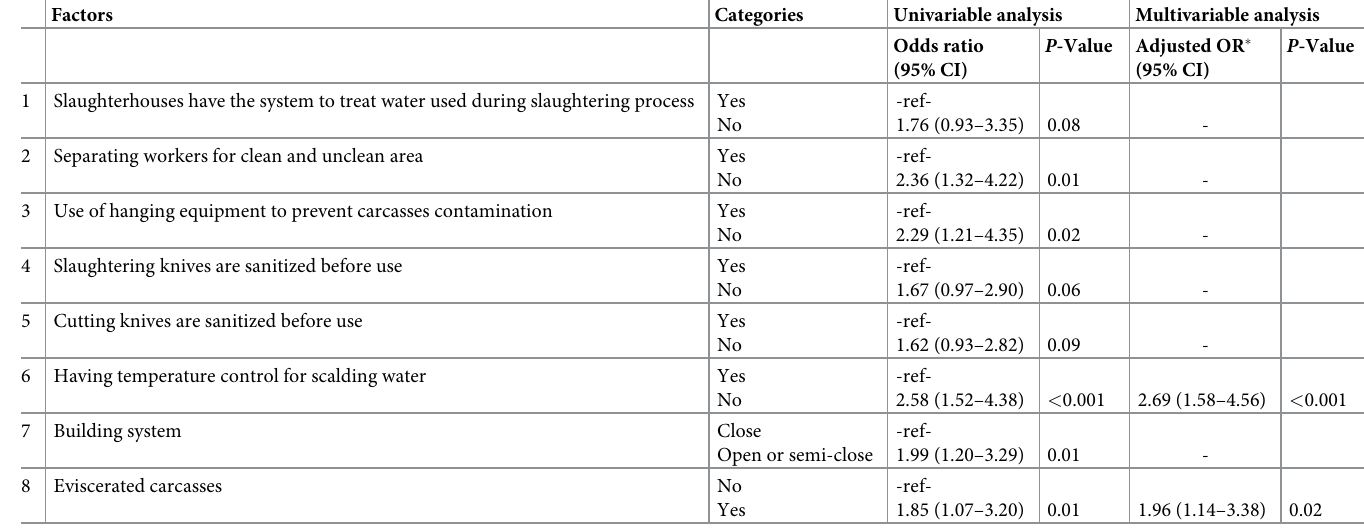
Table 6. Factors associated with the Escherichia coli non-compliance of meat samples based on the univariable and multivariable mixed-effects logistic regression.